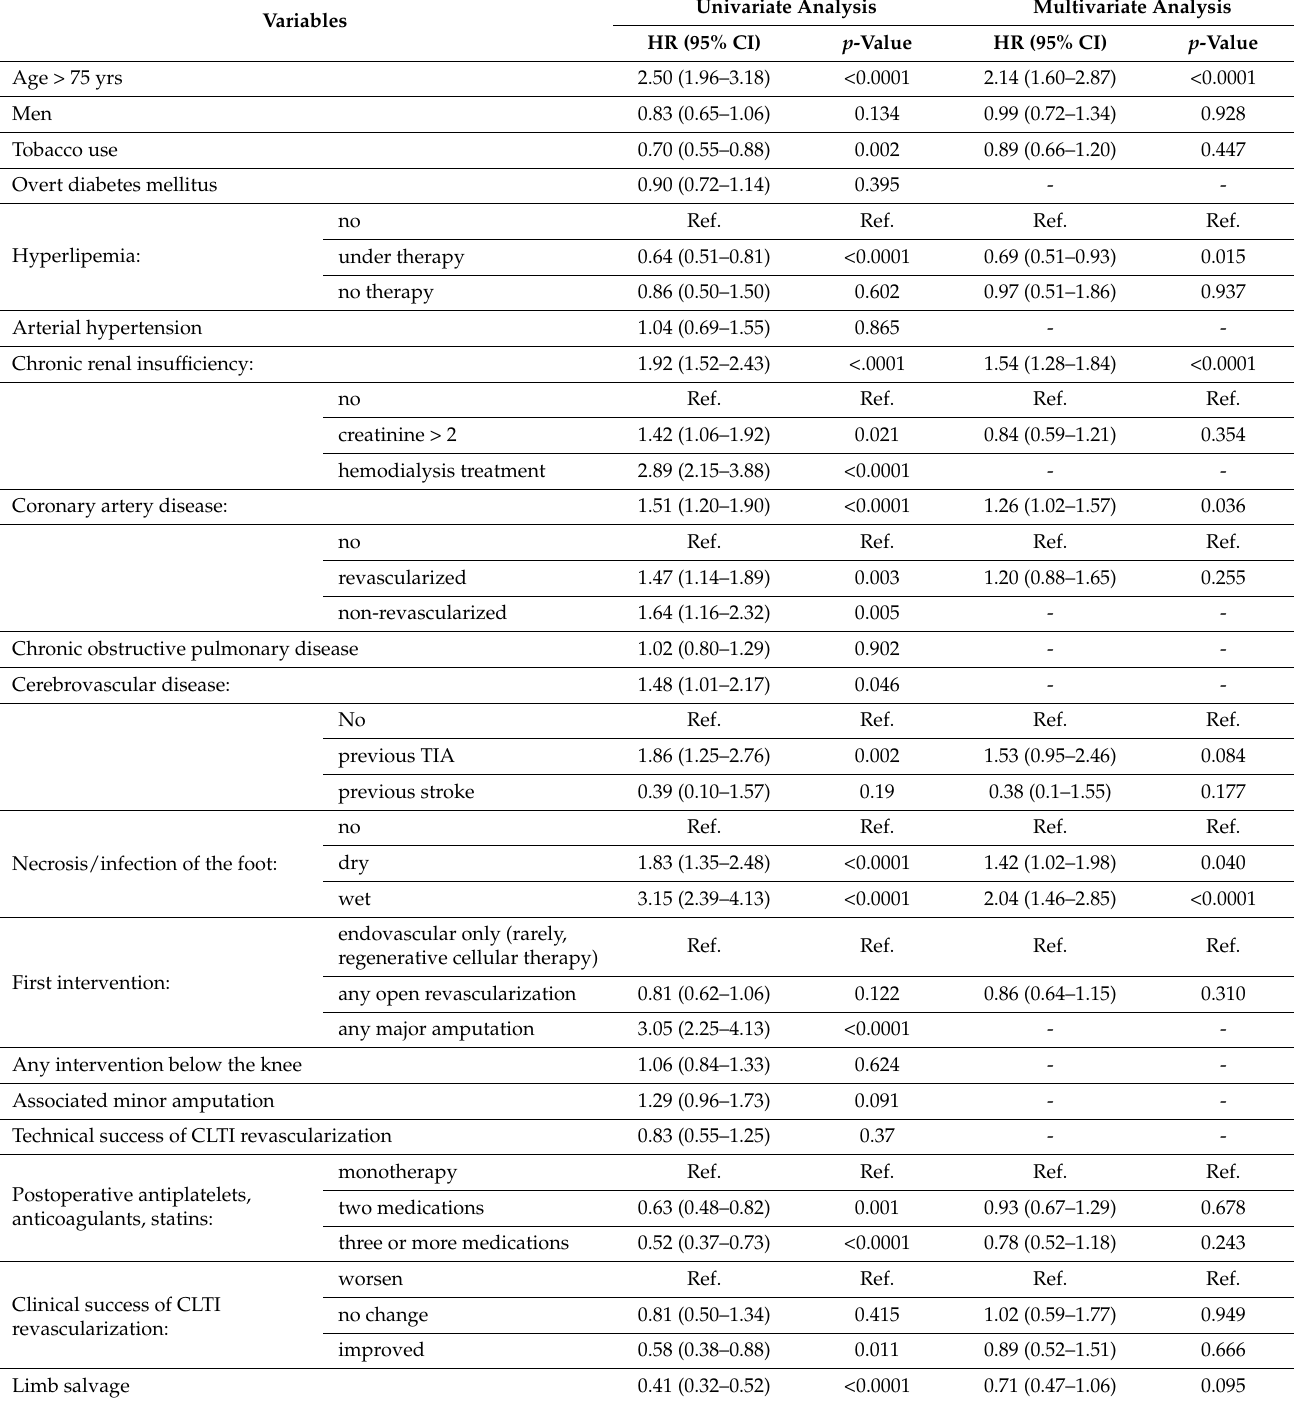
Table 3. Cox regression analysis to assess risk factors for 1 year